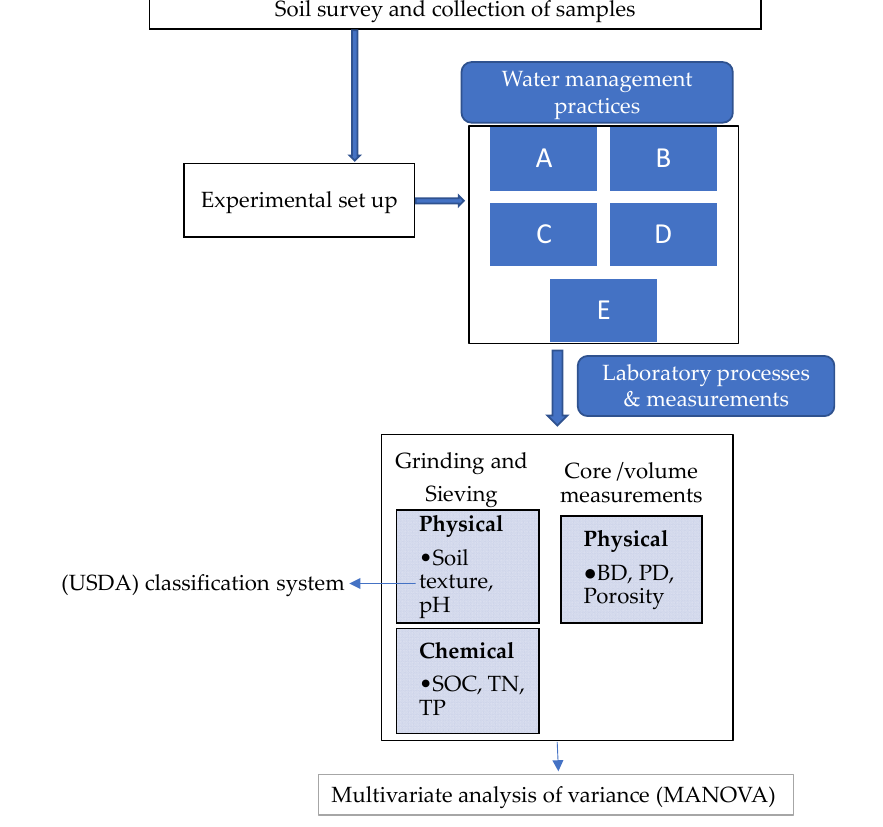
Figure 2. Flow chart for field experimental design and laboratory procedures and analyses. Letters A = traditional flood irrigation (rainfed) without intensification of rice farming, B = traditional flooding (rainfed) with rice intensification (SRI), C = AWD farming practice involving SRI with one cropping season, D = abandoned fields, and E = AWD farming practice involving SRI with two cropping seasons. BD—bulk density; PD—particle density; SOC—soil organic carbon; TN—total nitrogen; TP—total phosphorous.